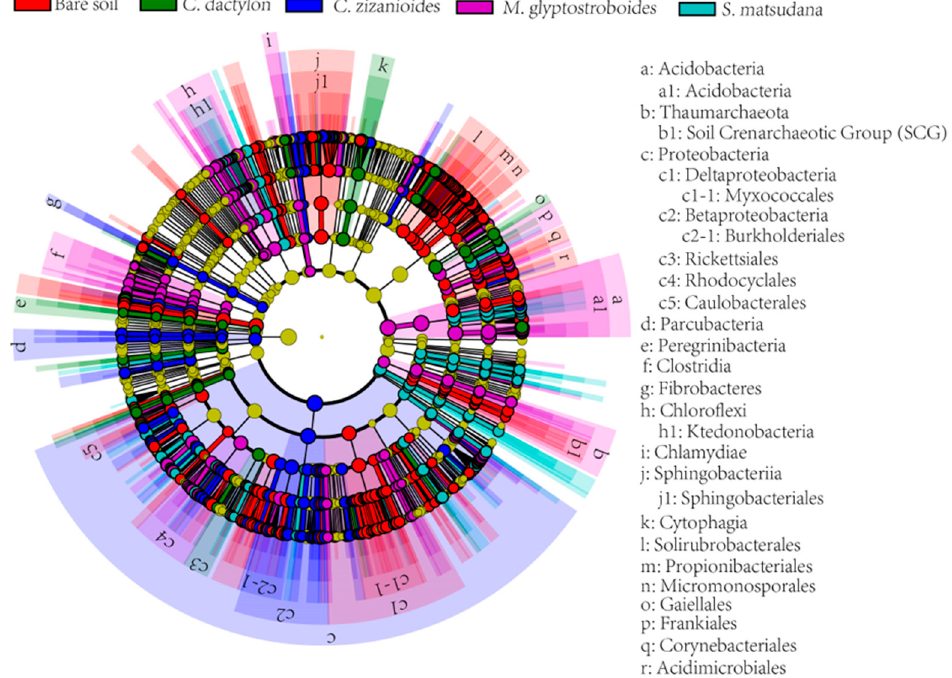
Figure 6. Identification of the most differentially abundant taxa between different samples by using the online statistical linear discriminant analysis effect size (LEfSe) tool.